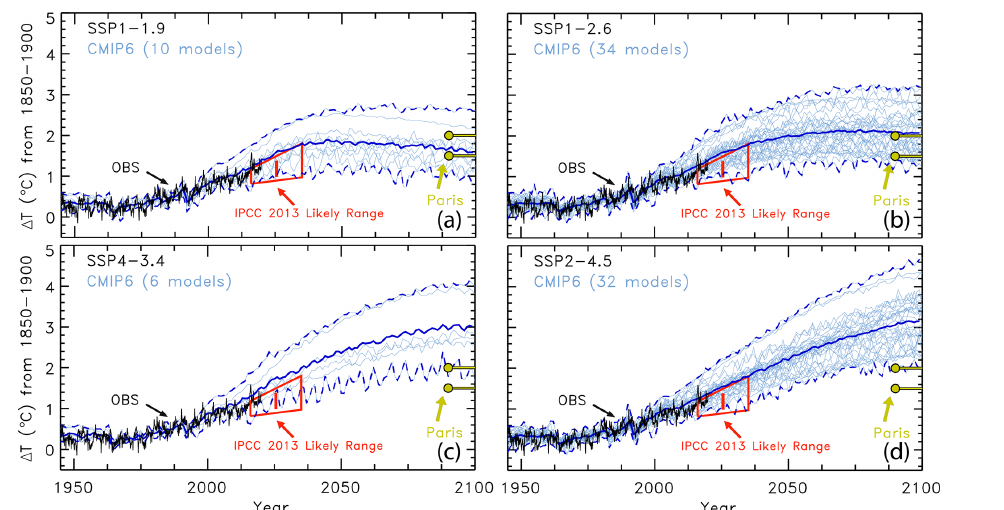
Figure 9. Historical simulations and future projections of GMST from the CMIP6 multi-model ensemble for several SSP scenarios. (a) GCM simulations from the historical experiment and future model projections from SSP1-1.9. Observations (black) are from HadCRUT5 to the end of 2019. The IPCC 2013 likely range of warming (red) is from Fig. 11.25b in Chapter 11 of the IPCC 2013 report. The CMIP6 multi- model mean (thick, blue) and minimum and maximum (dashed, blue) lines are shown. Global monthly (cid:49)T was created by averaging the TAS output over the globe with a cosine latitude weighting. The Paris Agreement target of 1.5 ◦ C and upper limit (yellow) of 2.0 ◦ C are included to demonstrate how the GCM projections compare. (b) Future GMST projections from SSP1-2.6. (c) Future GMST projections